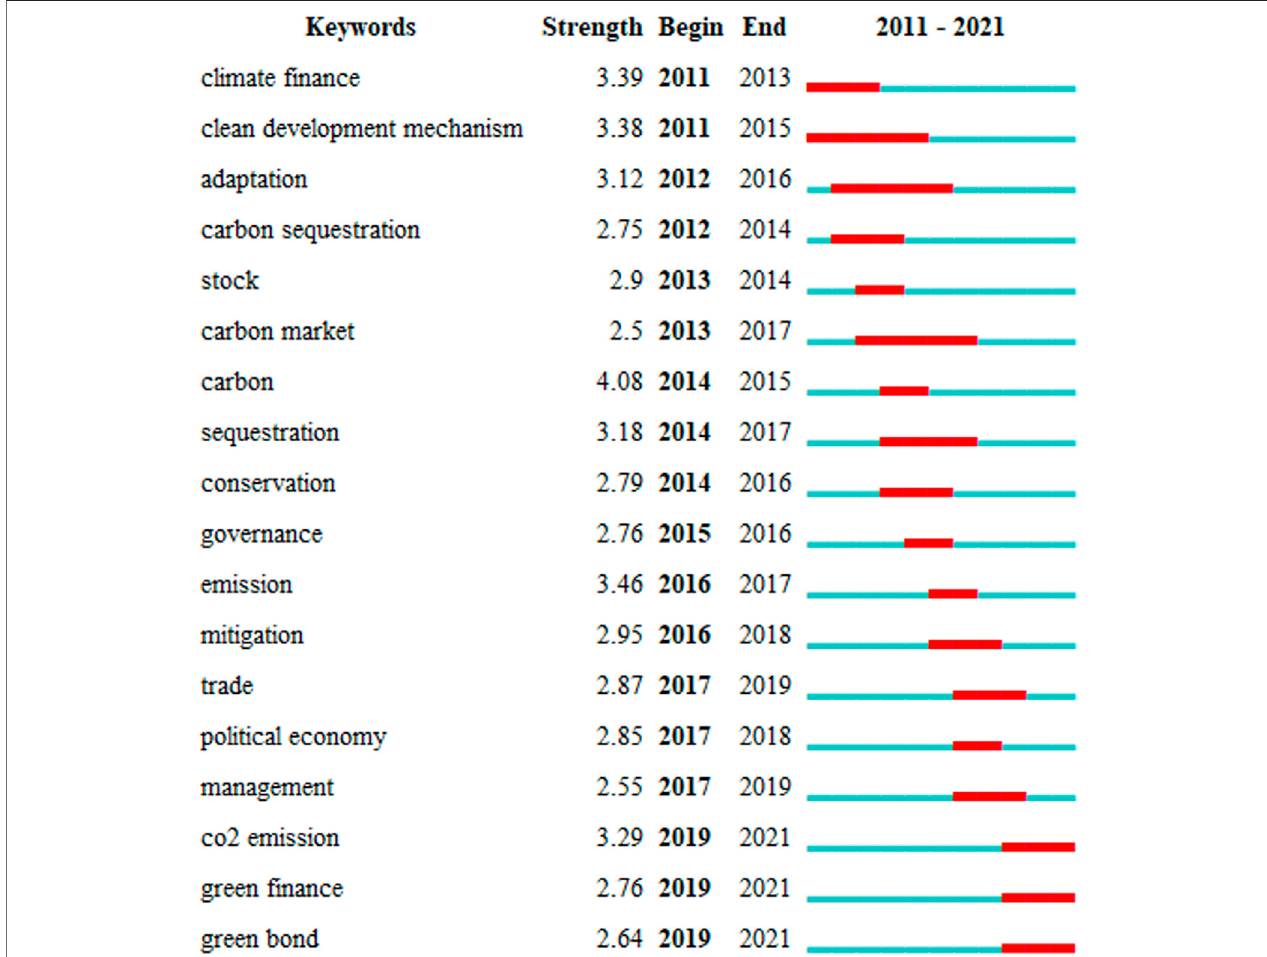
FIGURE 11 | High burstiness of keywords. The green line represents the period during which the keyword appeared, and the red line indicates the period during which the keyword received wide attention.